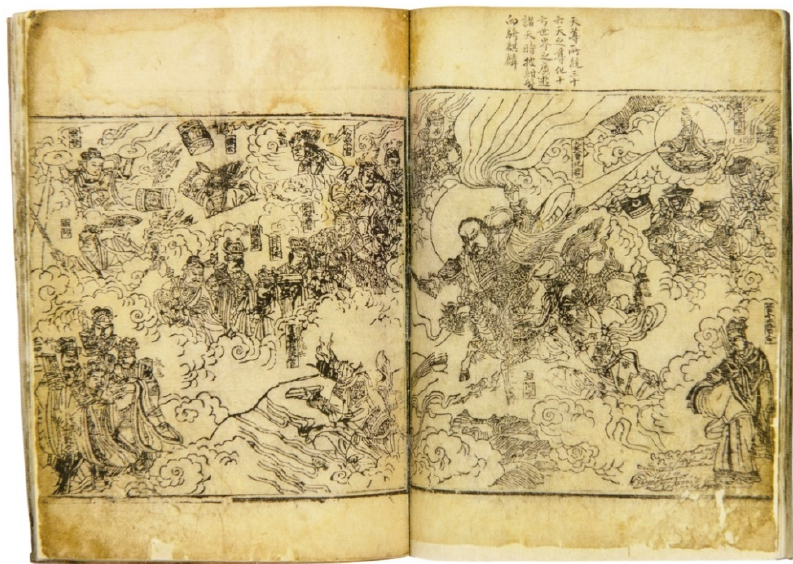
Figure 7. Illustration from the Ansim Monastery print of the annotated Yushu baojing , 1570, Chosŏn dynasty. Booklet, illustrated woodblock print. 33.8 cm × 26.1 cm. Collection of Woodblock Print Museum, Wŏnju, Kangwŏn Province, South Korea. Reproduced with permission from Woodblock Print